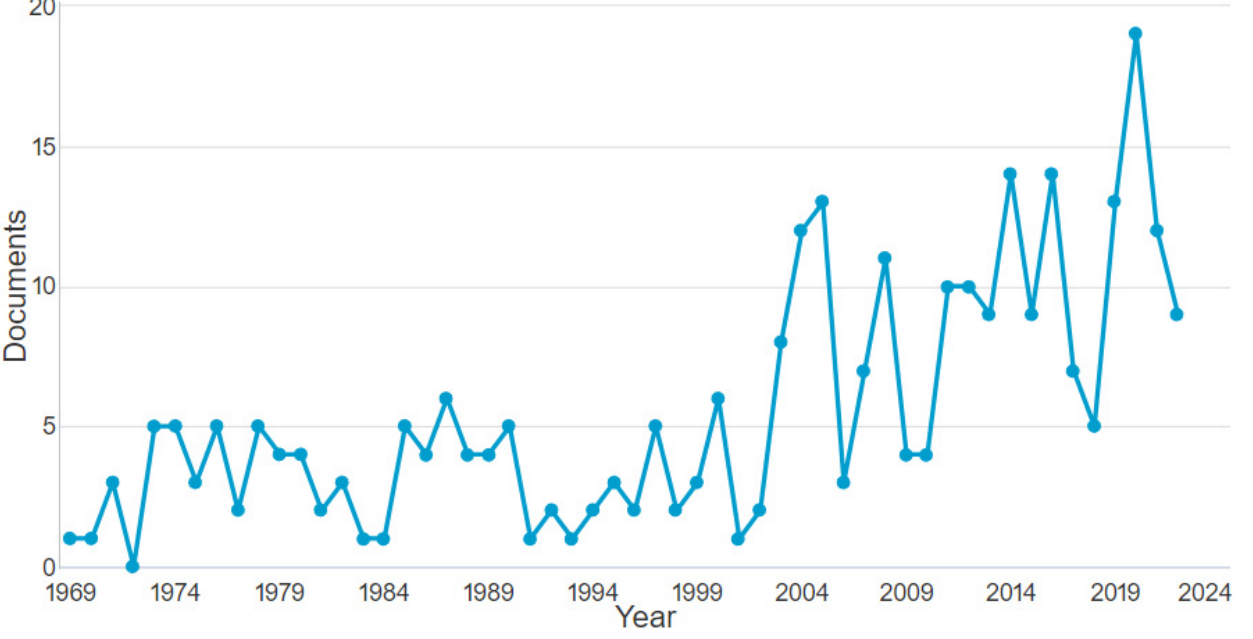
Figure 4. The number of publications on “marine hose” research (data retrieved from Scopus database, 24 July 2022).